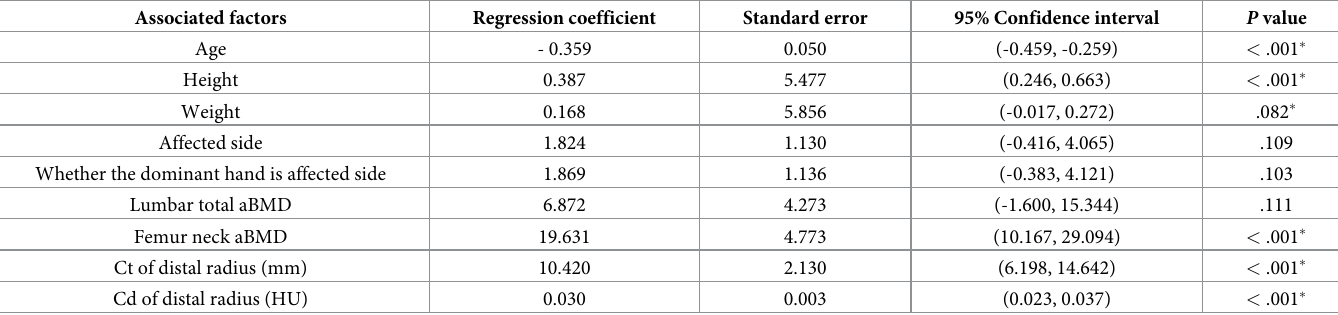
Table 4. Univariate linear regression analysis of factors related to handgrip strength.